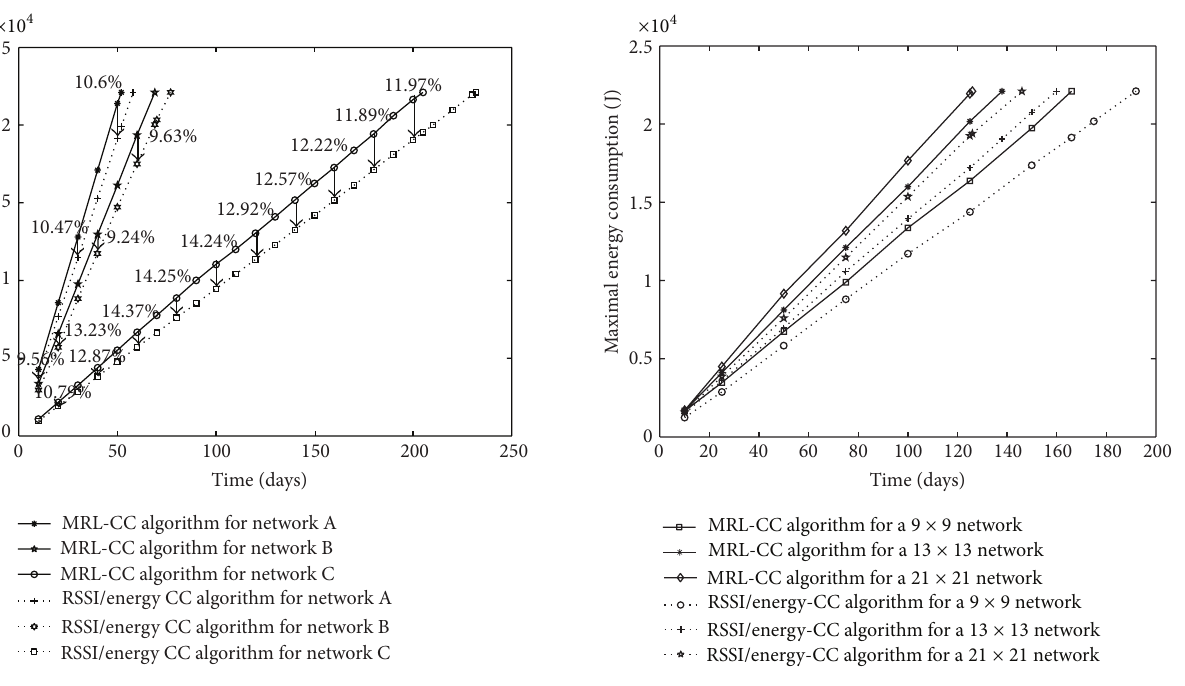
network energy consumption is saved for the RSSI/energy CC algorithm compared to the MRL-CC algorithm. Network energy consumption is saved up to 9.49% for 9 × 9 network, up to 6.78% for 13 × 13 network, and up to 6.08% for 21 × 21